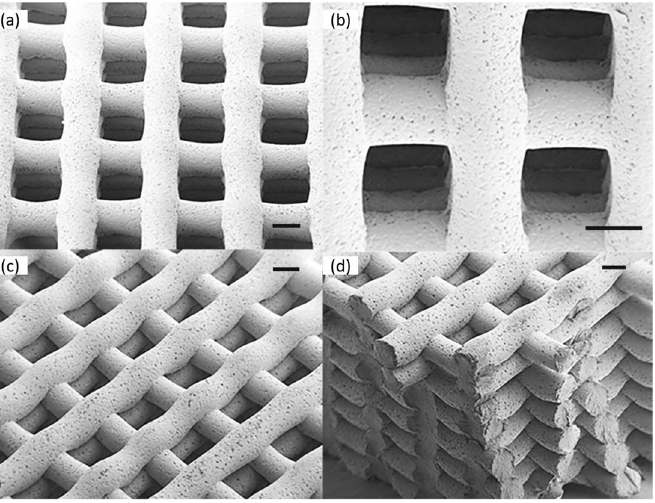
Figure 3. SEM images of 3Dprinted copolymer impregnated with silver nitrate scaffolds at different magnifications ( a – d ) (scale bars: 200 μm). Reprinted with permission from [84].